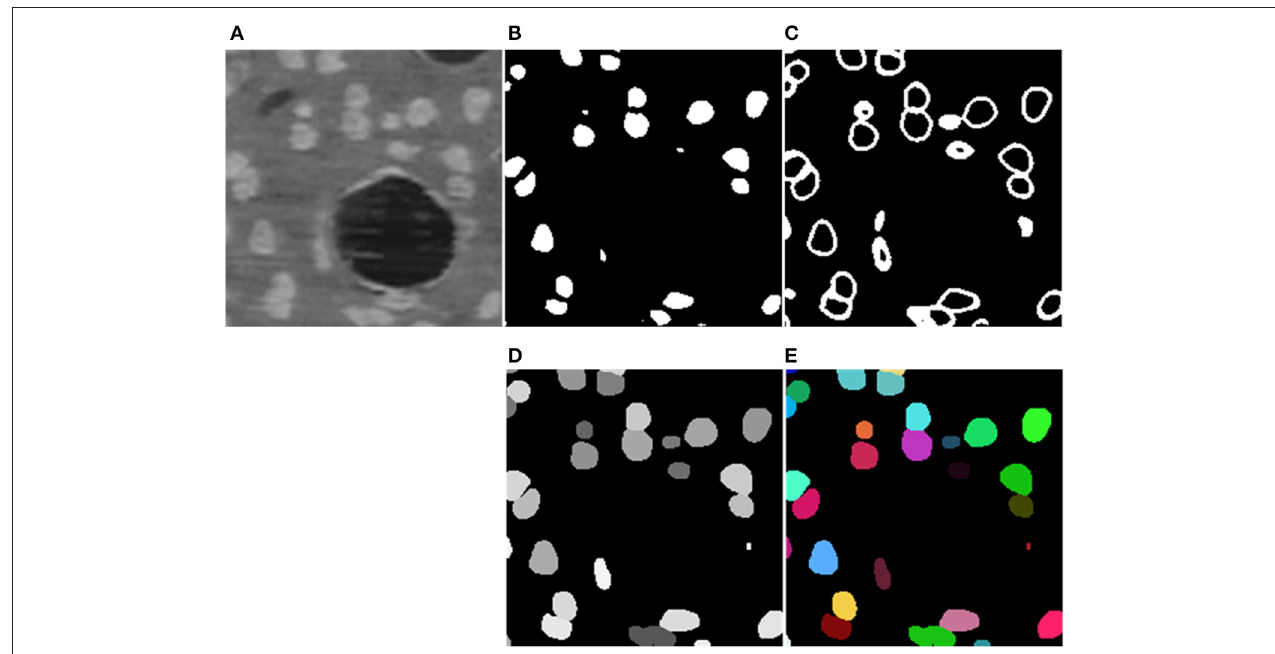
FIGURE 5 | Segmentation Steps. (A) Raw data. (B,C) Predicted boundary and object for each neuronal soma. (D) Refined segmentation results where individual neuronal somata are labeled by unique gray levels. (E) Neuronal soma labeled by unique random color.